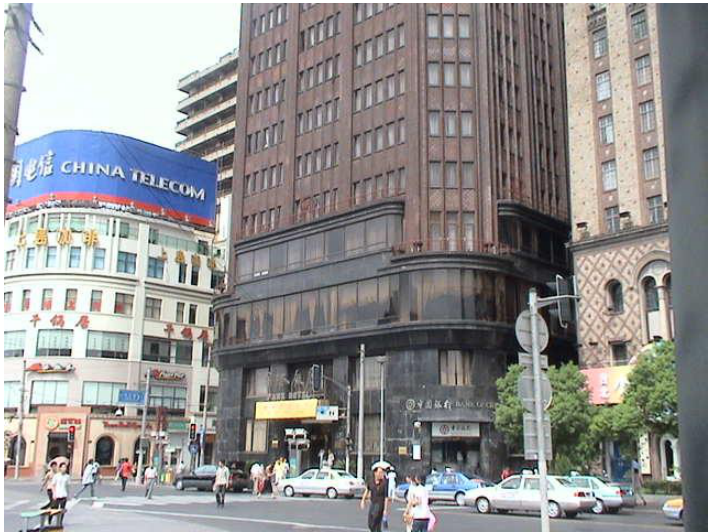
Figure 16. Lower levels of the Park Hotel .